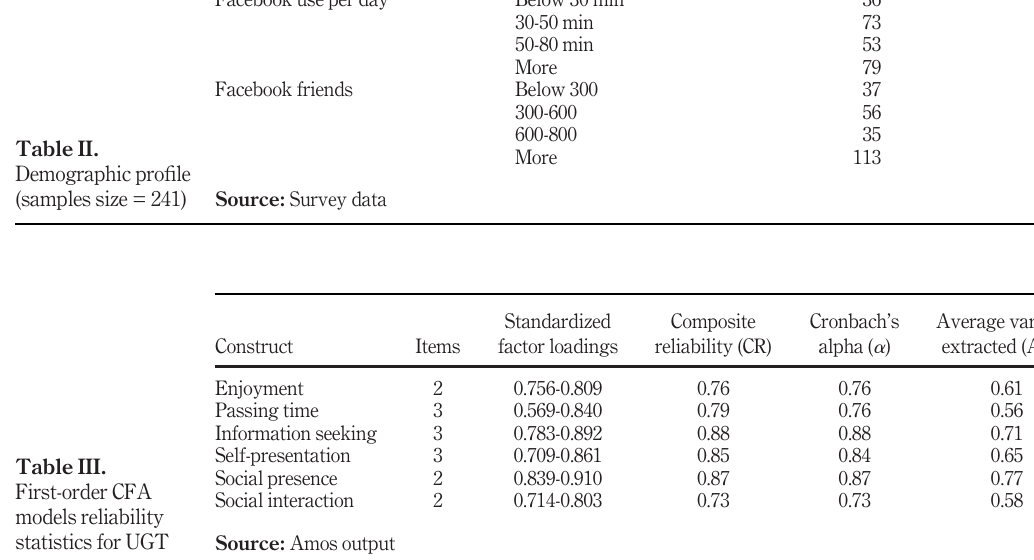
Table III. First-order CFA models reliability statistics for